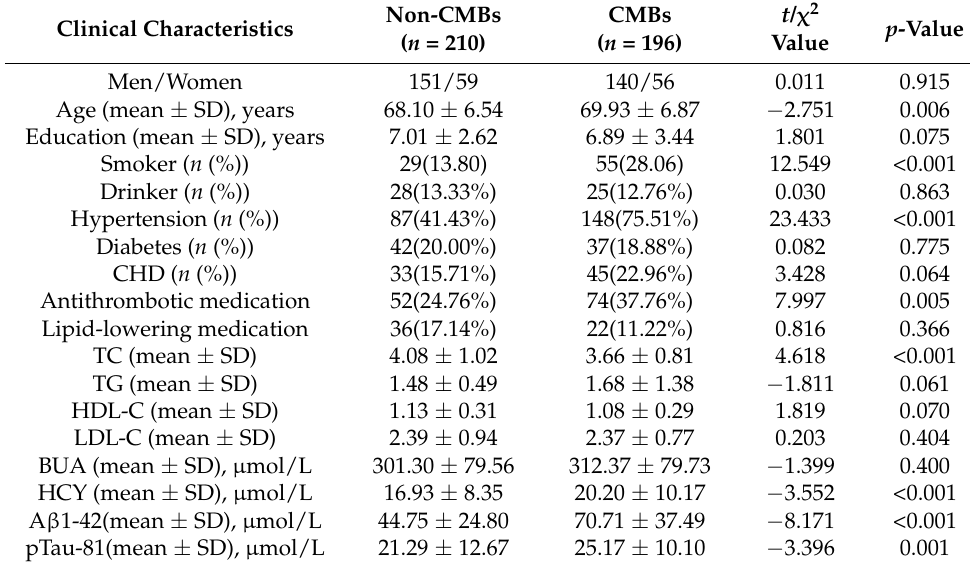
Table 1. Characteristics of the study population grouped according to the presence or absence of CMBs.